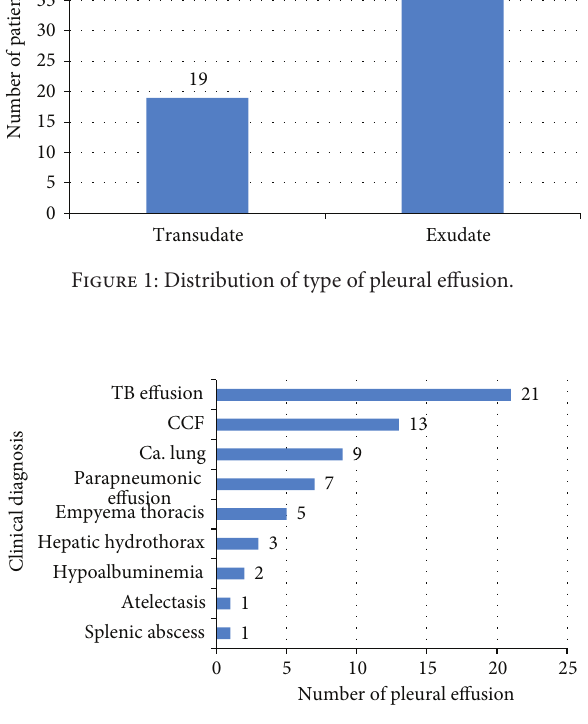
F 2: Distribution of causes (clinical diagnosis) of pleural effusion.